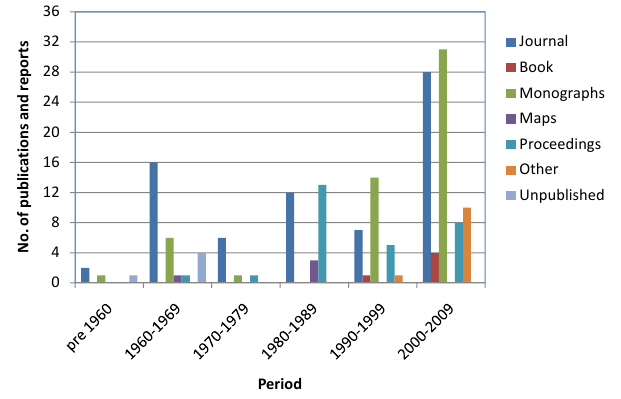
Fig. 5. Chronology of the documentation on the Vaiont landslide. data (geomechanical stations, faults, lithology, etc.). A raster dataset is a data structure representing a generally rectangular grid of pixels, or points of colour. In the GIS, raster datasets of varying formats are usually used to represent